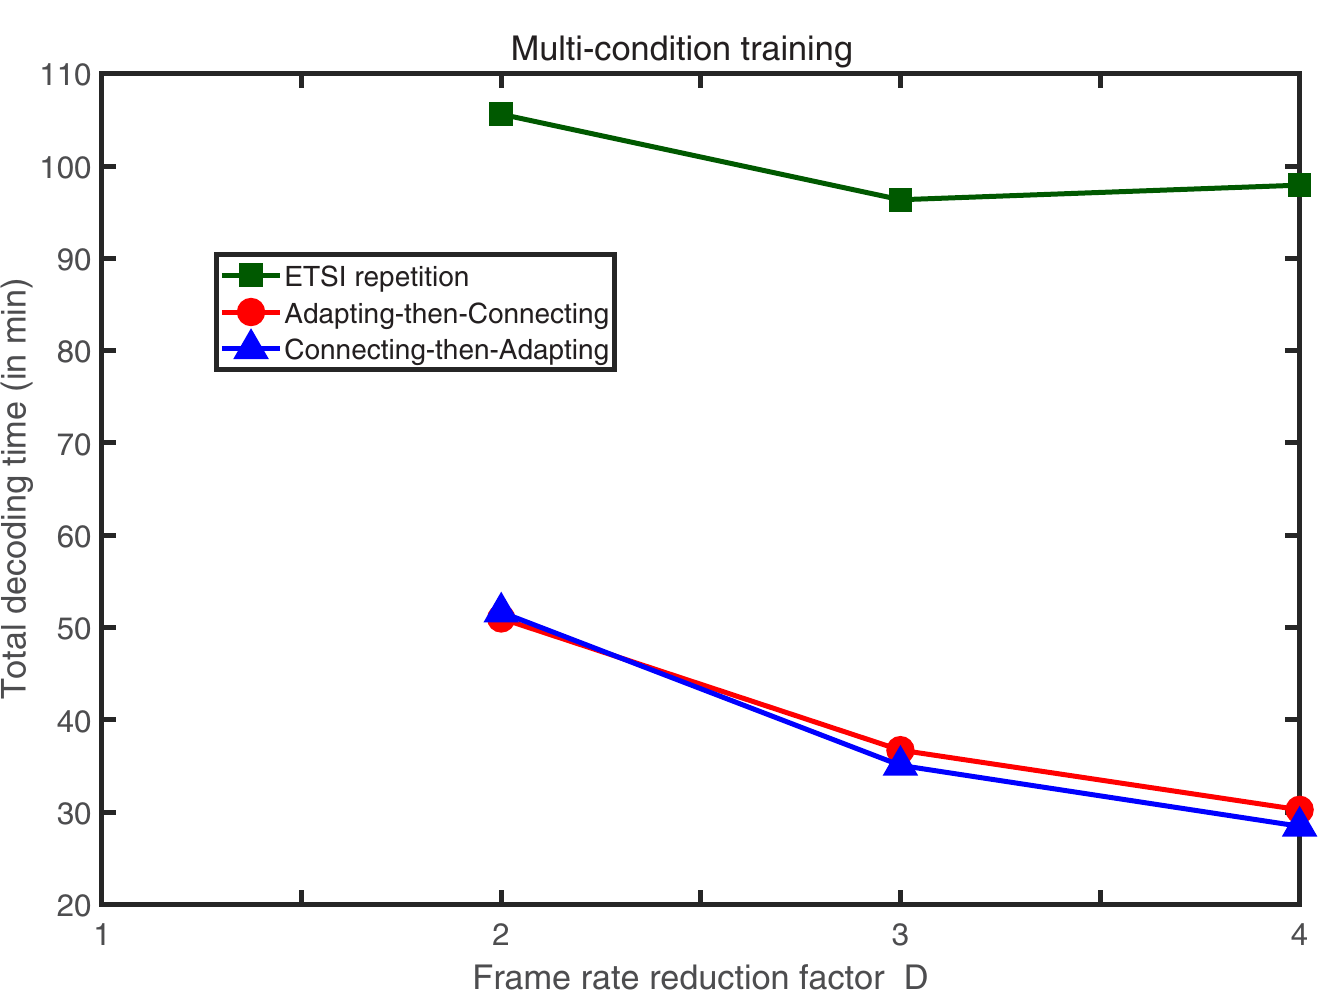
Fig 14. The total decoding time of all three test data sets of AURORA 2 with multi-condition training for the ETSI repetition and the two adaptation approaches.